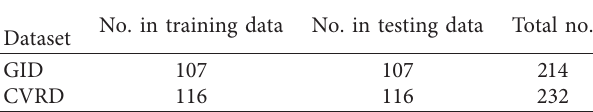
Table 3: Number of samples in the training and testing